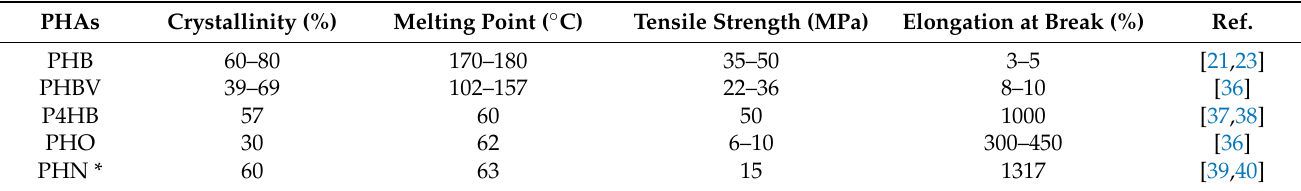
Table 1. Properties of various PHA-derived polymers.